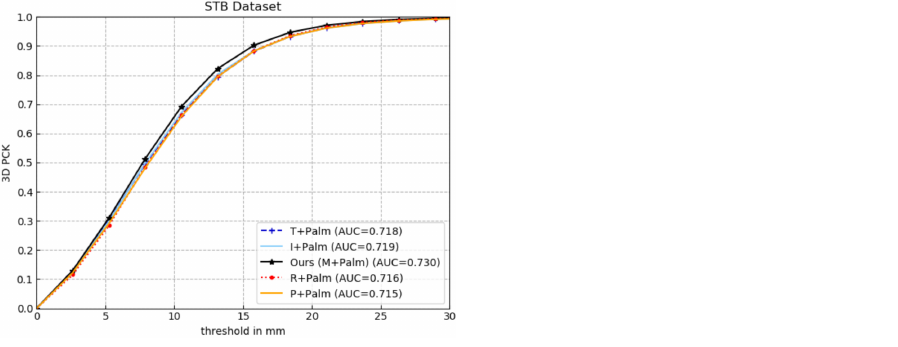
Figure 7. Comparative experiment of the effectiveness of the Palm connecting with middle finger. Table 4. Error analysis of connecting Palm with middle finger.